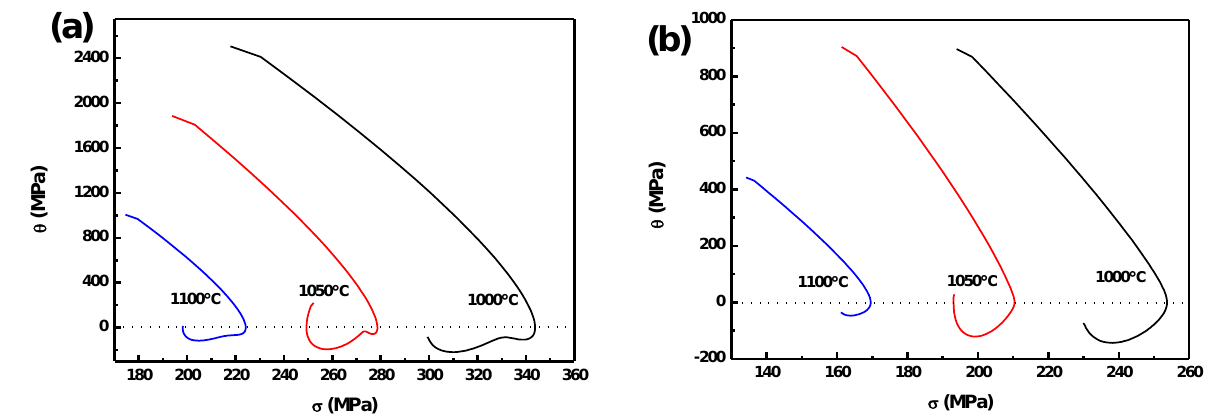
Figure 5. Curve of θ - σ 1 s − 1 at three temperatures, under two strain rates ( a ) 10 s − 1 and ( b ) 1s − 1 .